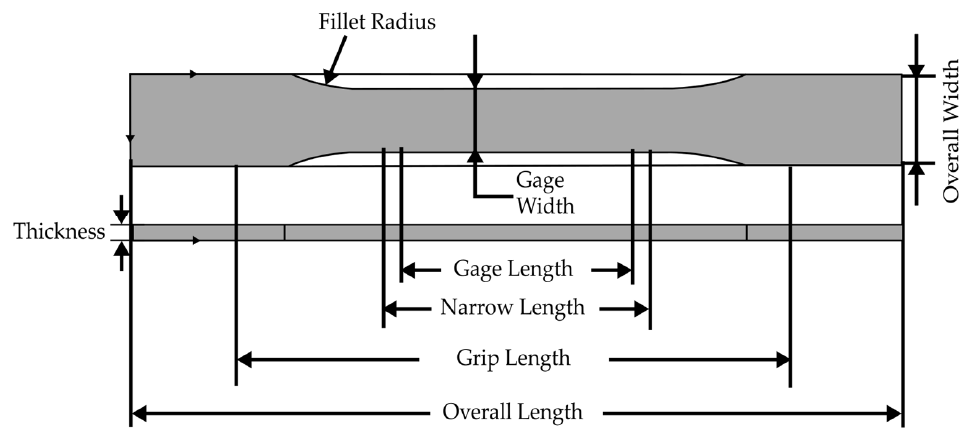
Figure 9. Specimen of tensile testing [149].